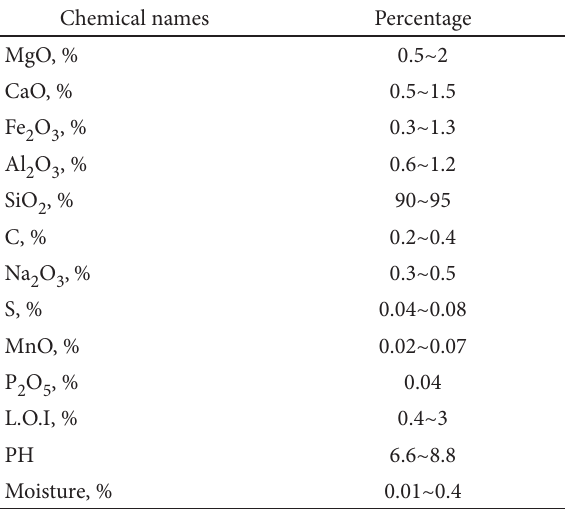
Table 3. Results of chemical analysis of